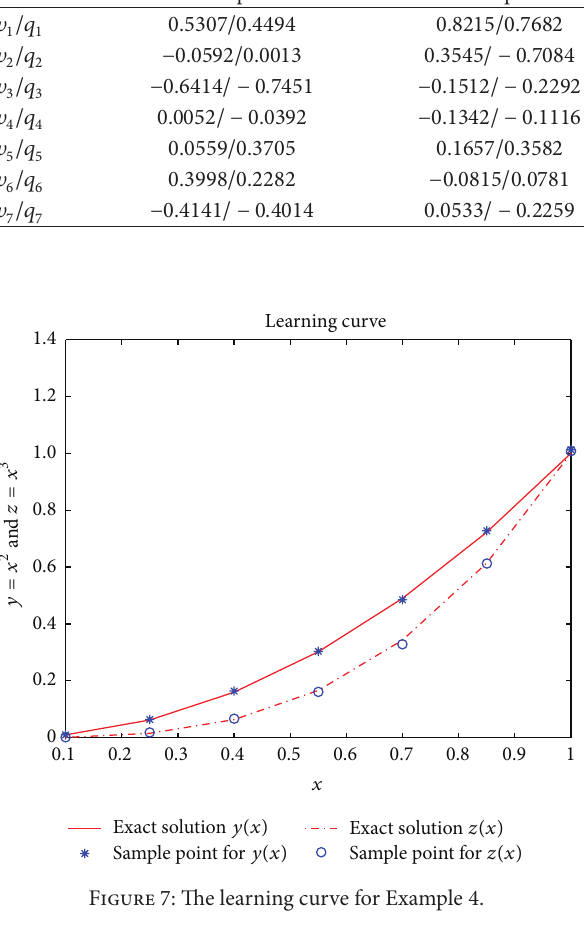
Figure 7: The learning curve for Example 4.